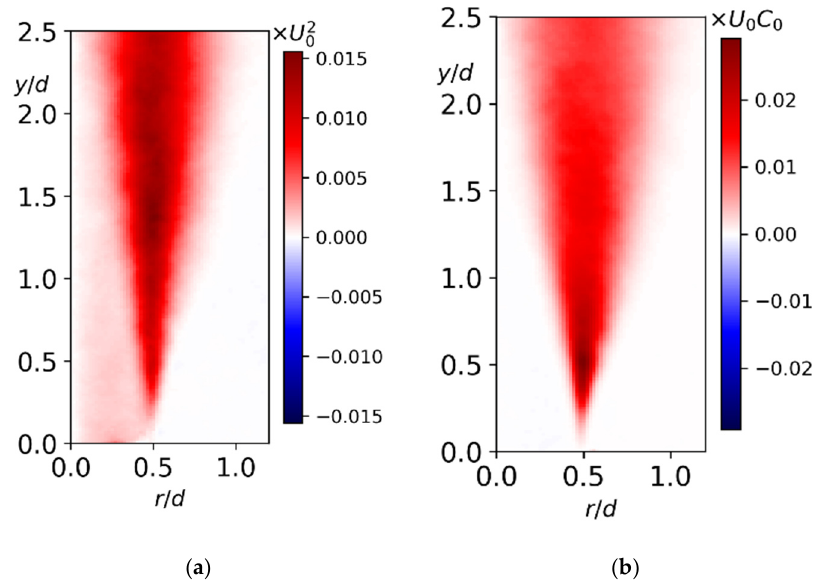
Figure 7. ( a ) Axial-radial Reynolds shear stress and ( b ) radial turbulent flux for nonswirling jet.